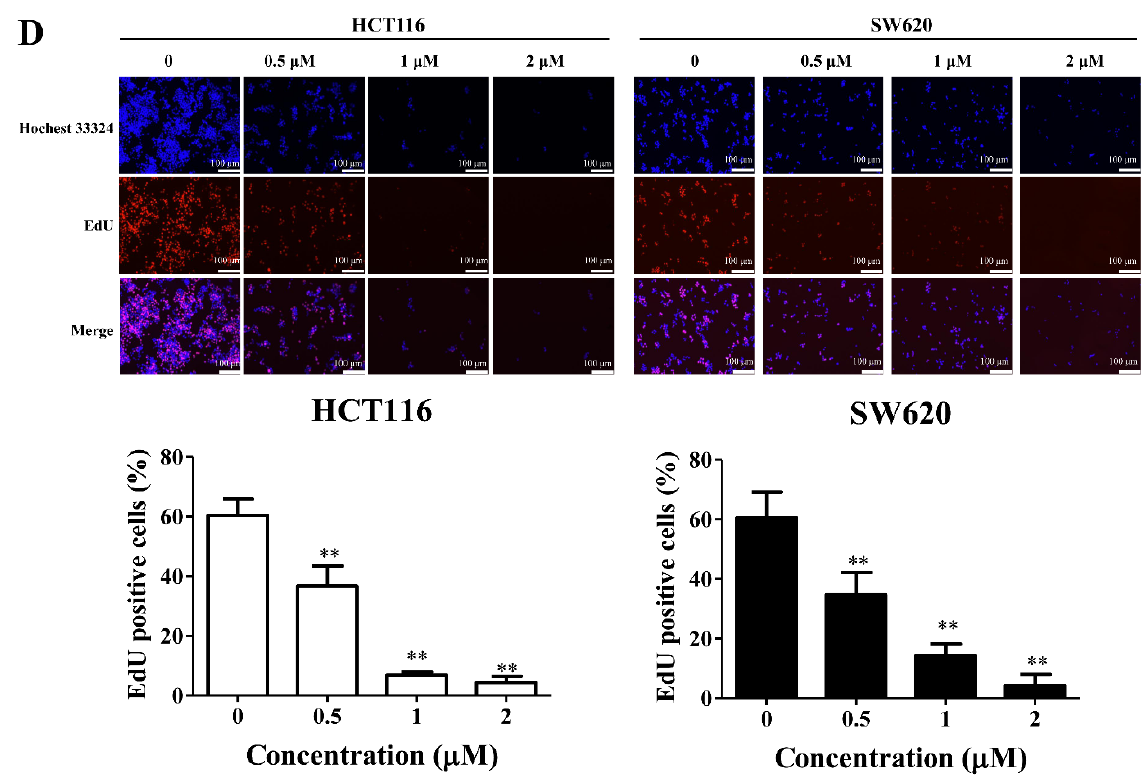
Figure 1. PPII inhibits the proliferation of CRC cells. ( A ) Chemical structure of PPII. ( B ) PPII reduced the viability of CRC cells. Cells were treated with various concentrations of PPII for 24 or 48 h. Cell viability was measured with MTT assays. ( C ) PPII reduced the colonies of CRC cells. The representative results (left panels) and quantitative results (right panel) are shown. ( D ) Effect of PPII on the proliferation of CRC cells was determined using the EdU staining assays. The nuclei were stained using Hoechst33342. The ratio of EdU-positive cells is presented in lower panels. The data shown are the means ± SD of three independent experiments. ** p < 0.01 vs. vehicle control.